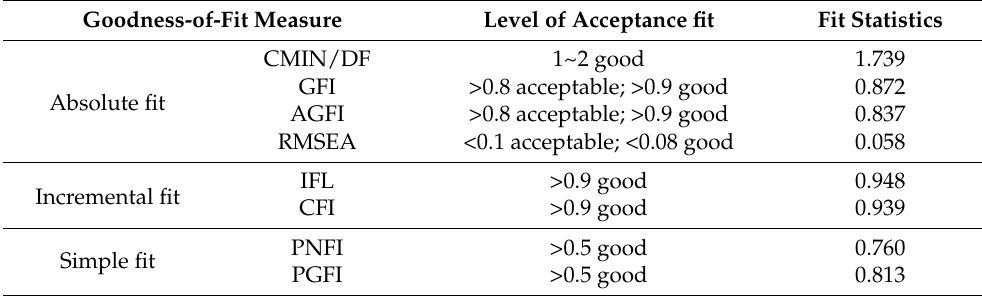
Table 6. Goodness-of-fit of the final model. Goodness-of-Fit Measure Level of Acceptance